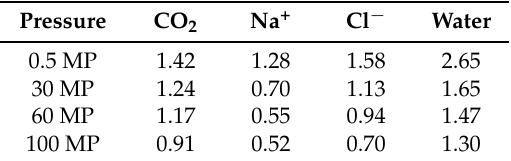
Table 3. The pressure dependence of D i (×10 − 5 cm 2 /s) at 275 K.